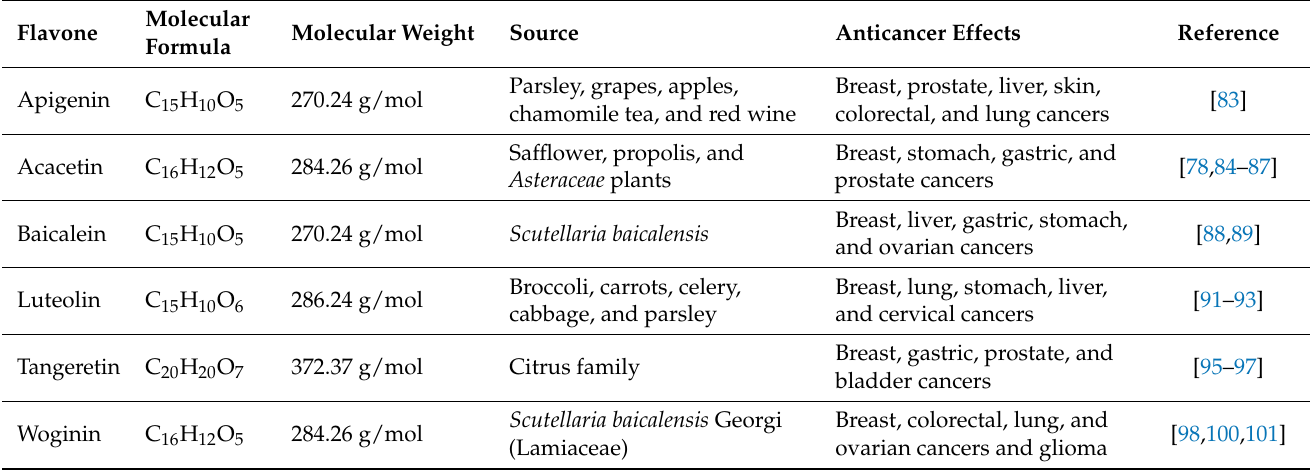
Table 2. The six selected flavones with anticancer